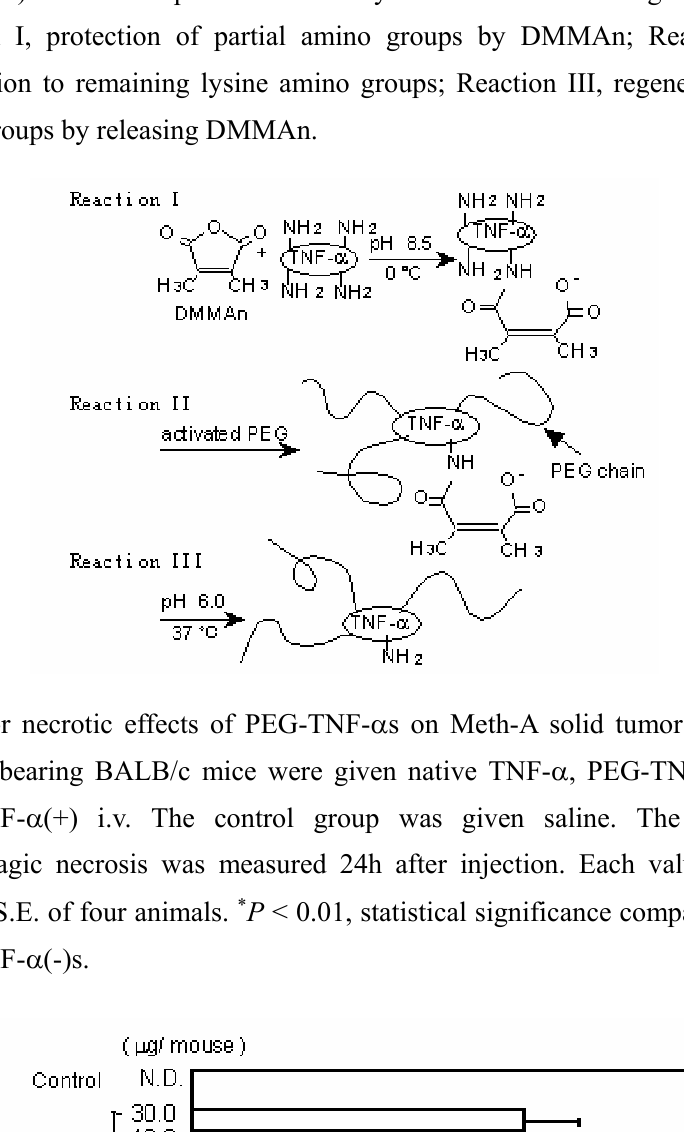
Figure 3. A novel polymer-conjugation technique with a reversible amino-protective reagent. a) Schematic protocol of PEGylation of TNF- α using